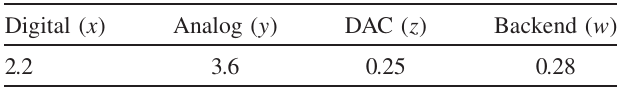
TABLE IV. Component wise contribution in mV rms.